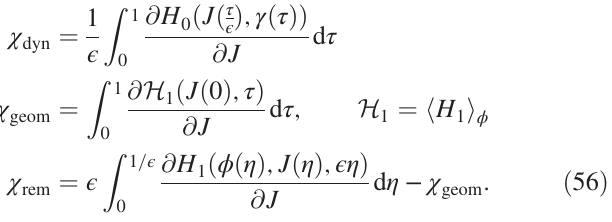
FIG. 2. Phase portraits of the Hamiltonian (52) with α δ ¼ − 0 . 44 (right), in Cartesian ð X ; Y Þ coordinates. The orbits that pass through X ¼ 0 , Y ¼ (cid:2)